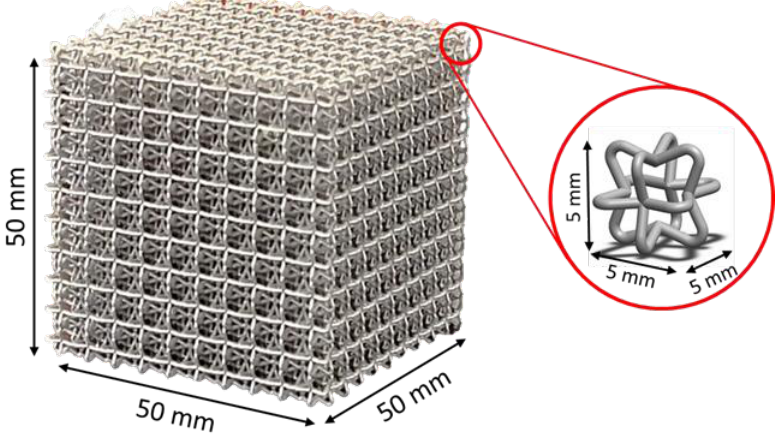
Figure 1. Cellular architecture of the